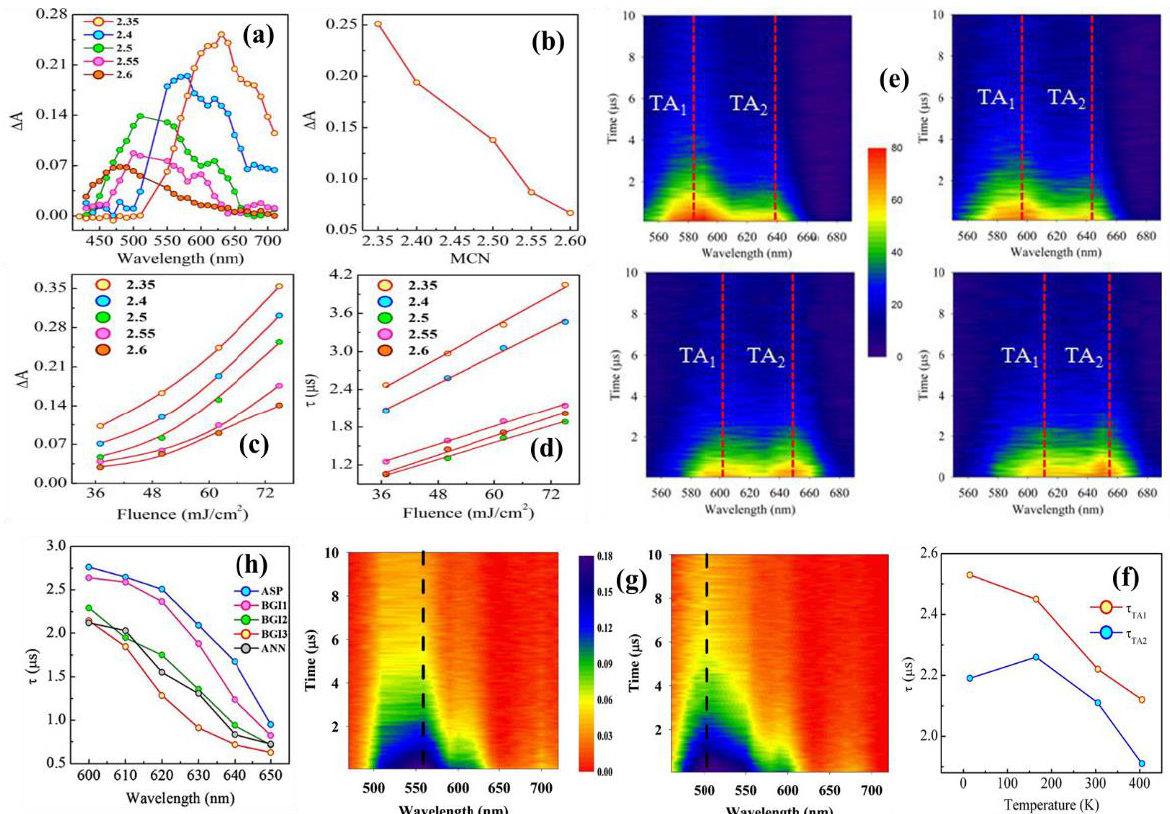
Figure 9. ( a ) Transient absorption (TA) spectra of a-Ge x As 35-x Se 65 thin films when illuminated with ns pump laser at fixed probe delay of 200 ns. ( b ) Variation in the amplitude of TA maxima with MCN. ( c ) Change in TA maximum for samples with different MCN for various excitation fluence, which scales quadratically. ( d ) Change in decay time constant of TA for samples of different MCN that scales linearly with excitation fluence. Colored symbols represent experimental data, and the solid red lines indicate theoretical fit. ( e ) 2D contour plot depicting time-resolved TA spectra of a-Ge 5 As 30 Se 65 thin film at 15, 165, 305, and 405 K when illuminated with 532 nm, 5 ns pulsed laser. ( f ) Variation of τ 1 and τ 2 , associated with TA 1 and TA 2 against temperature changes. All Figures are reprinted with permission from [56] Copyright 2014, Springer Nature. ( g ) 2D contour plot of the TA for as-prepared (ASP) and background illumination (BGI) samples showing spectral and temporal evolution. The vertical dotted lines indicate the TA maxima for both samples. ( h ) The decay-time constant for ASP and BGI samples at different probe wavelengths shows TA is faster for BGI samples in comparison to ASP samples.